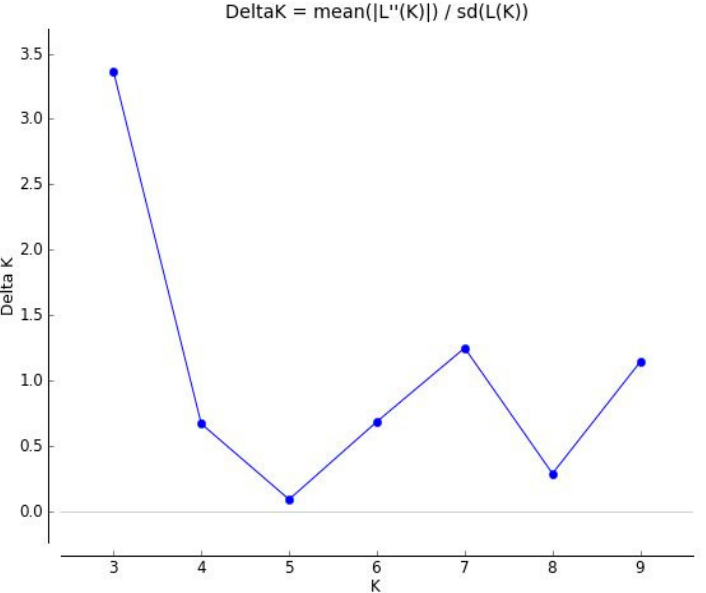
Figure 4. Delta K value proposing the presence of three populations of forage pea genotypes using iPBS-retrotransposons marker system.